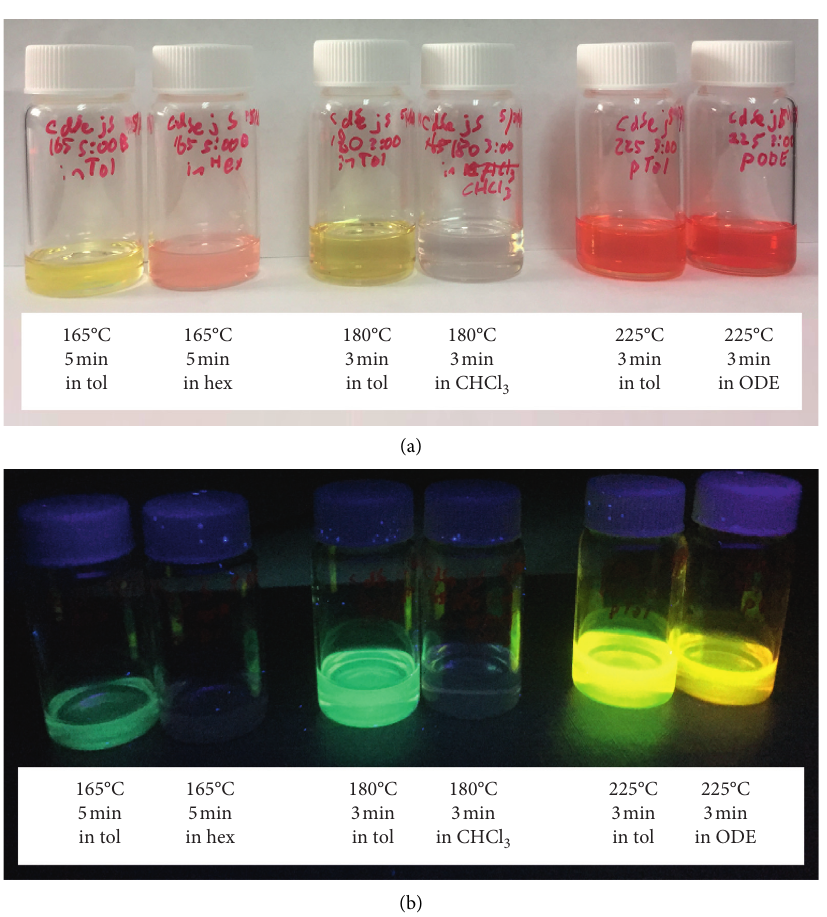
Figure 5: Comparison of QDs resuspended in different solvents under visible light (a) and 365nm UV light (b). The left pair compares QDs prepared at 165 ° C for 5min and resuspended in either toluene (left) or hexane (right). The middle pair compares QDs prepared at 180 ° C for 3min and resuspended in either toluene (left) or chloroform (right). The right pair compares QDs prepared at 225 ° C for 3 min and resuspended in either toluene (left) or 1-octadecene